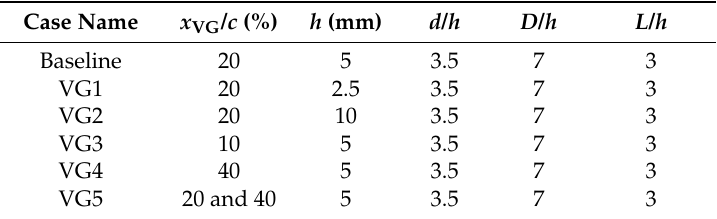
Figure 1. Schematic of the vane-type vortex generators. Nomenclature: h , vane height; L vane length; d , intra-vane spacing; D , inter-vane spacing; β , geometric vane inflow angle: ( a ) isometric view; ( b ) planar view. Table 1. Main parameters of the vortex generators simulated in this study.